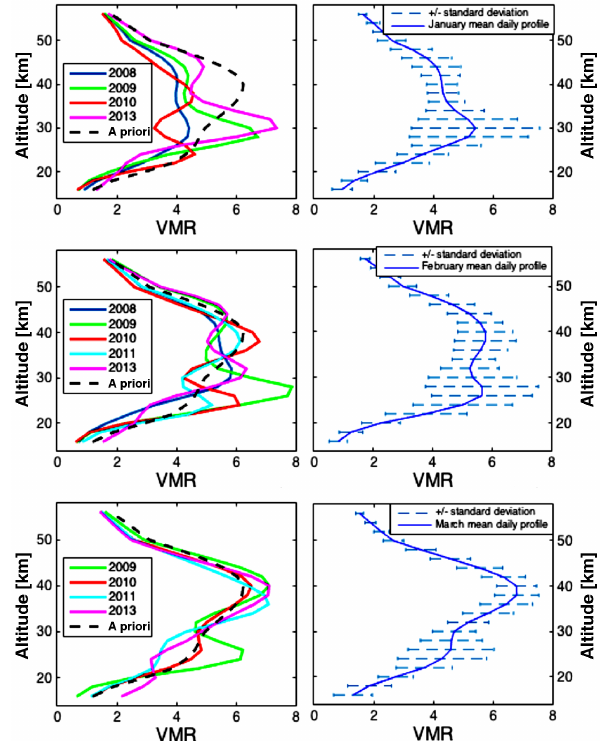
Figure 14. Left: monthly averages of daily Kiruna O 3 profiles (in ppmv) from KIMRA measurements for January, February, and March by year. A missing year means that there were not enough measurements during the month to produce a representative aver- age. Right: mean and standard deviation of the daily profiles for each